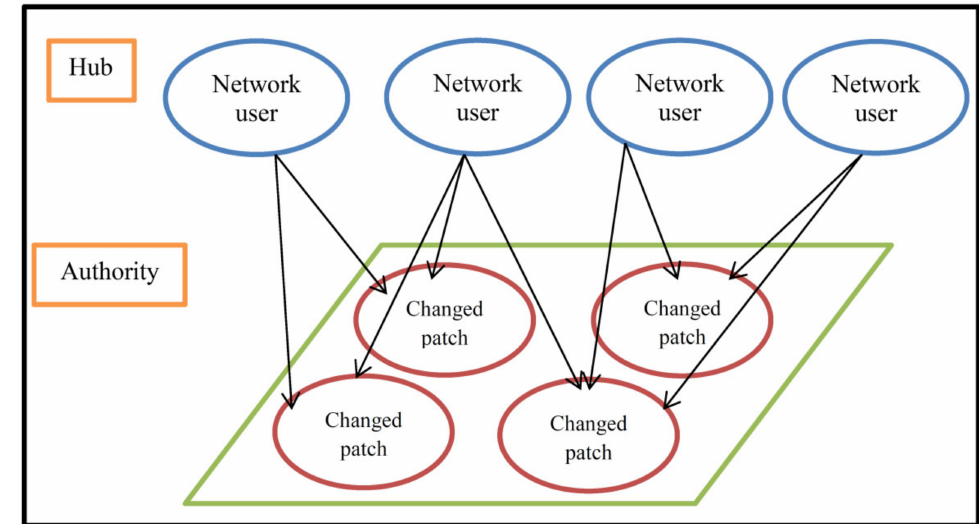
Figure 5. Bipartite graph of multiple users and changed